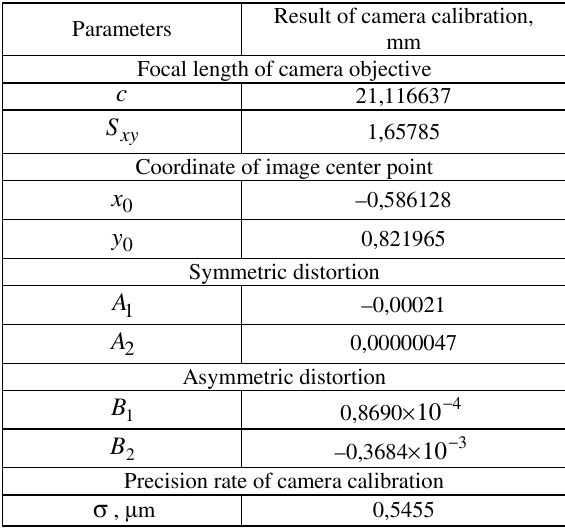
Table 1. Results of camera Canon EOS 350D calibration